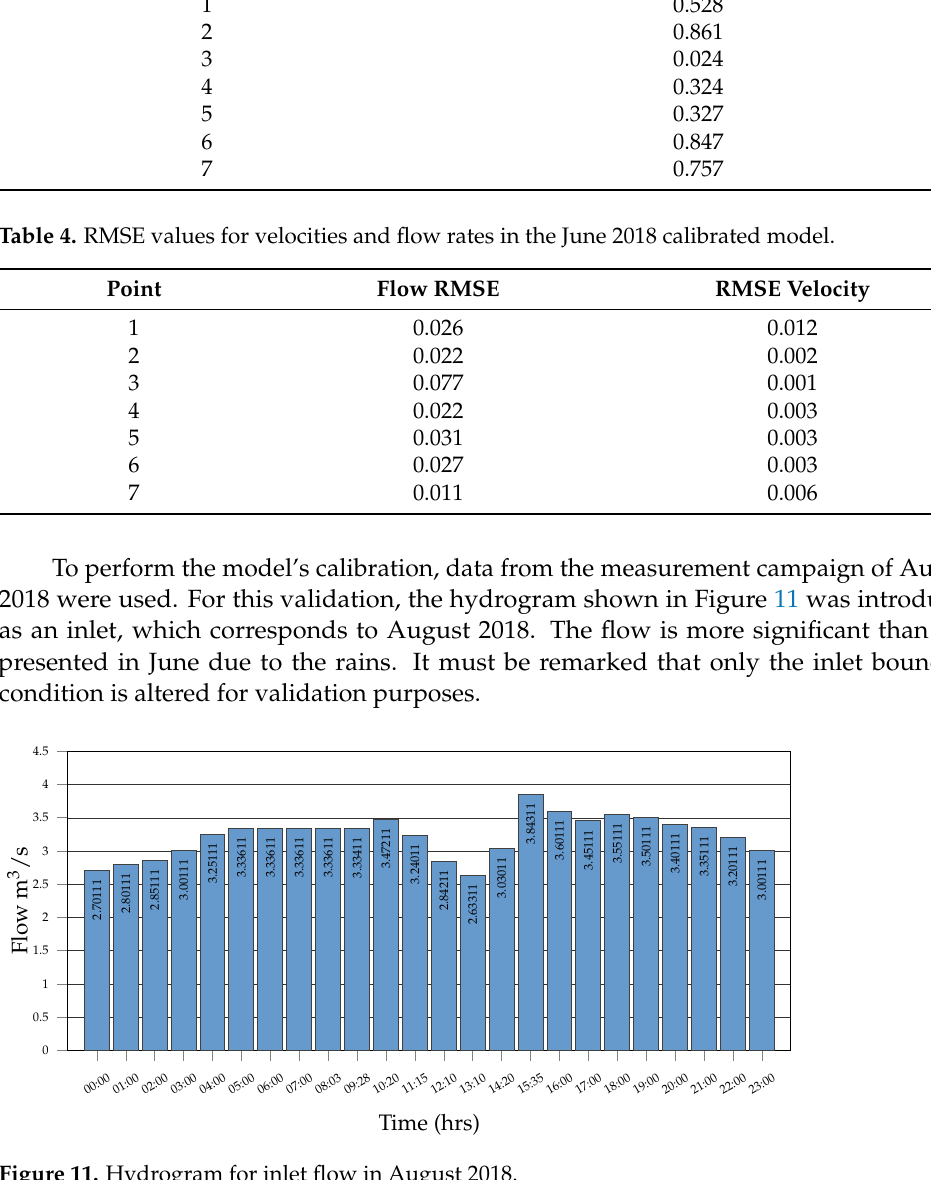
Figure 11. Hydrogram for inlet flow in August